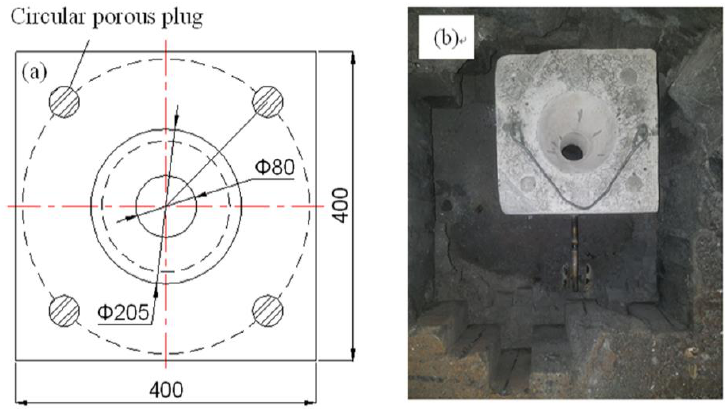
Figure 8. The porous plug of the new process integrated with the ladle nozzle well block: ( a ) the configuration; and ( b ) the installation in the ladle of a steel plant.